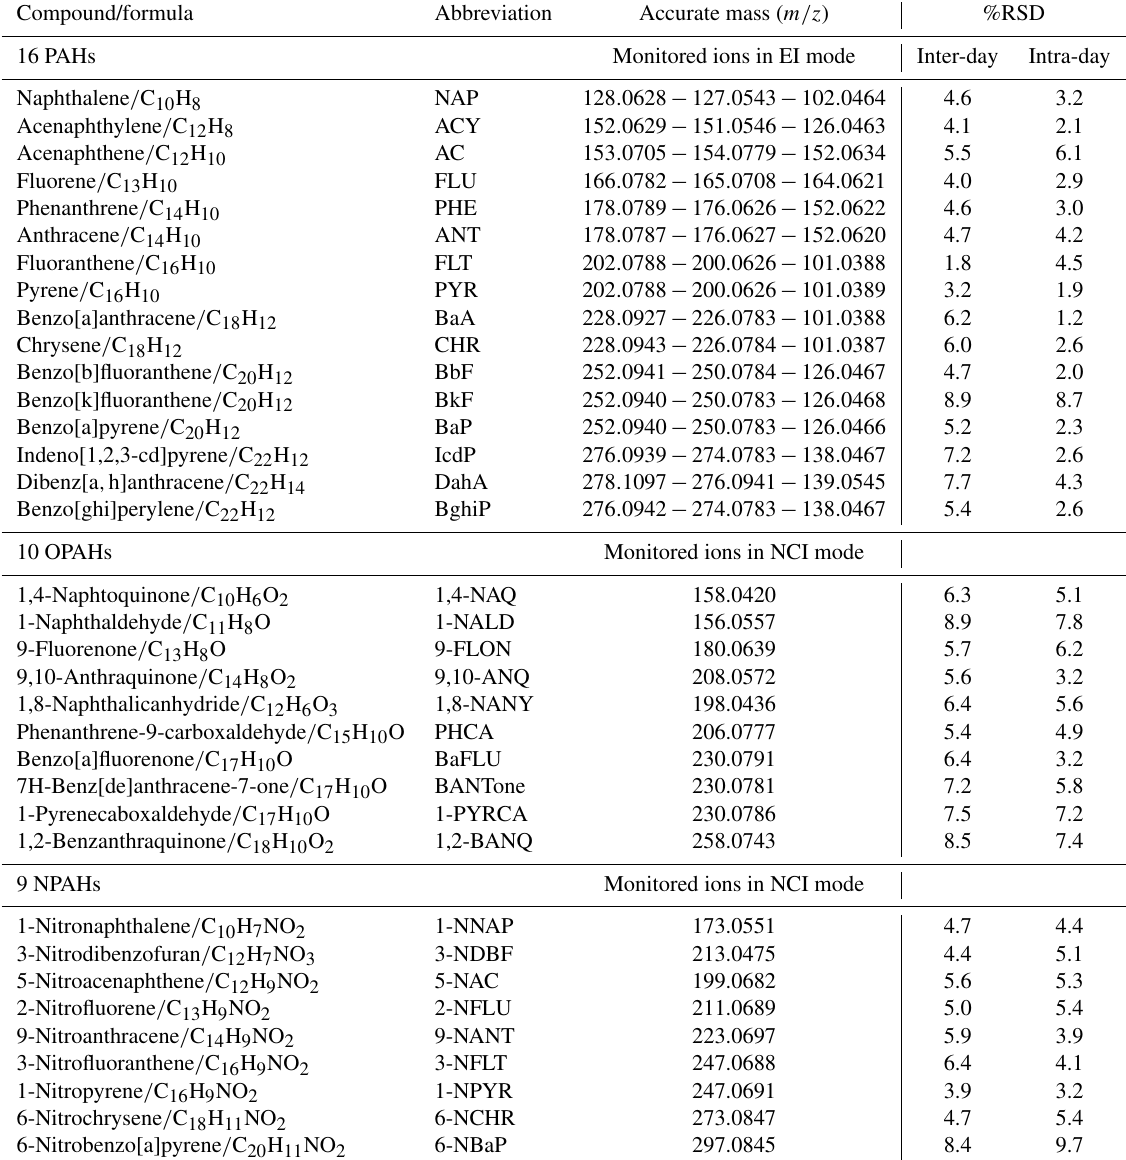
Table 1. List of measured PAHs, OPAHs and NPAHs and their abbreviations. Compounds are listed in order of elution. %RSD refers to the relative standard